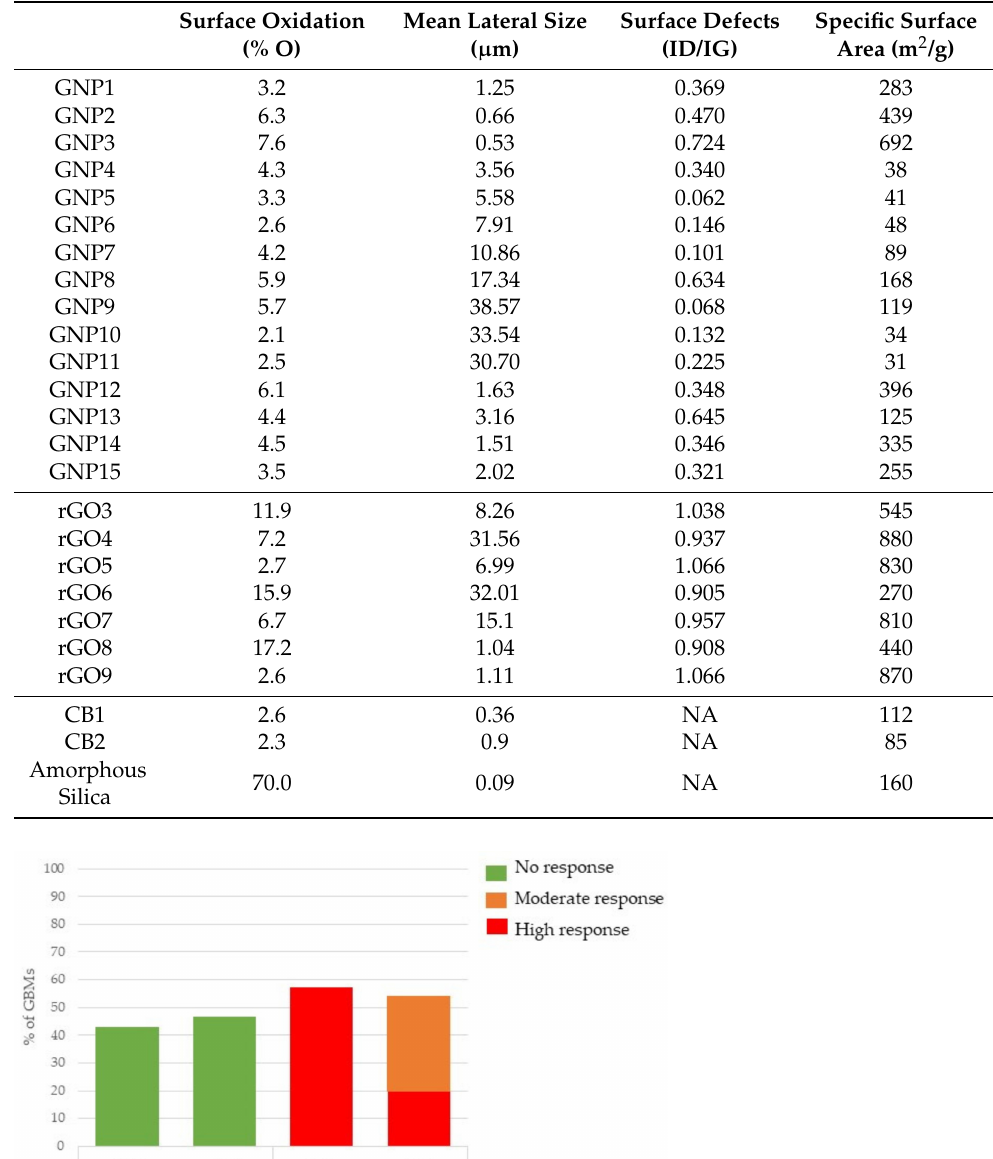
Table 1. Physicochemical features of the 22 GBMs, 2 carbon black and 1 amorphous silica.